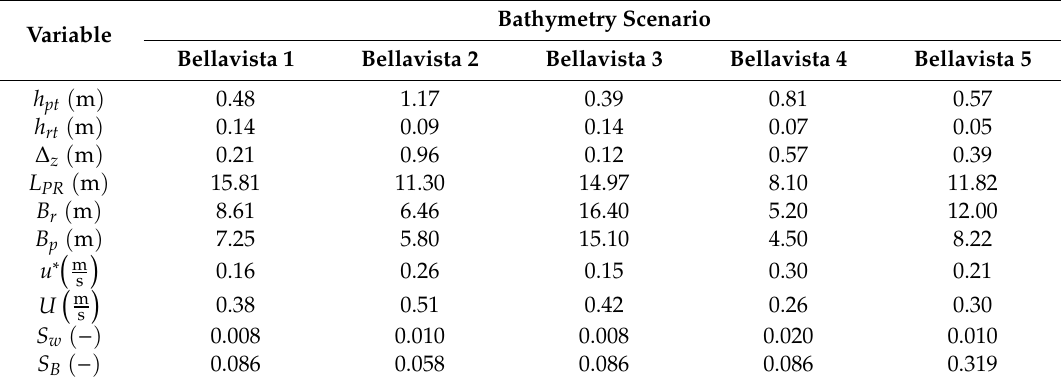
Table 4. Geometric and flow characteristics for each study reach.